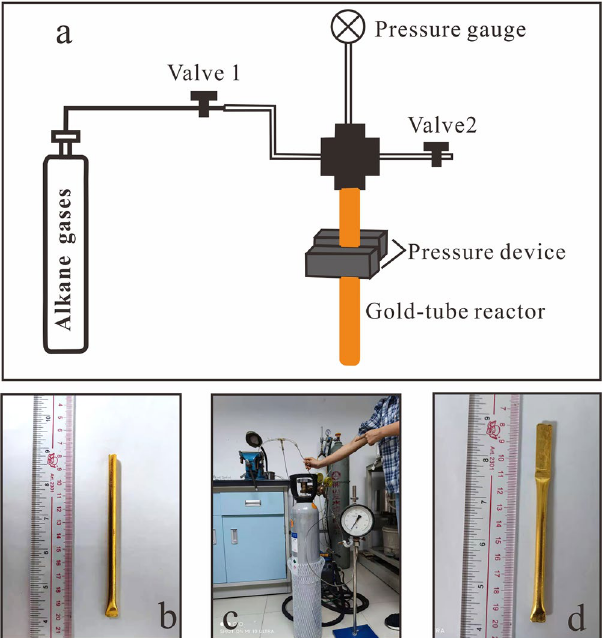
Figure 1. Schematic diagram of loading alkane gases into gold-tube reactors ( a ), picture of the gold tube with one end welded ( b ), picture of the device used to load gas into the gold tube ( c ), and picture of the gold tube after loading gas into and being welded in the other end ( d ).